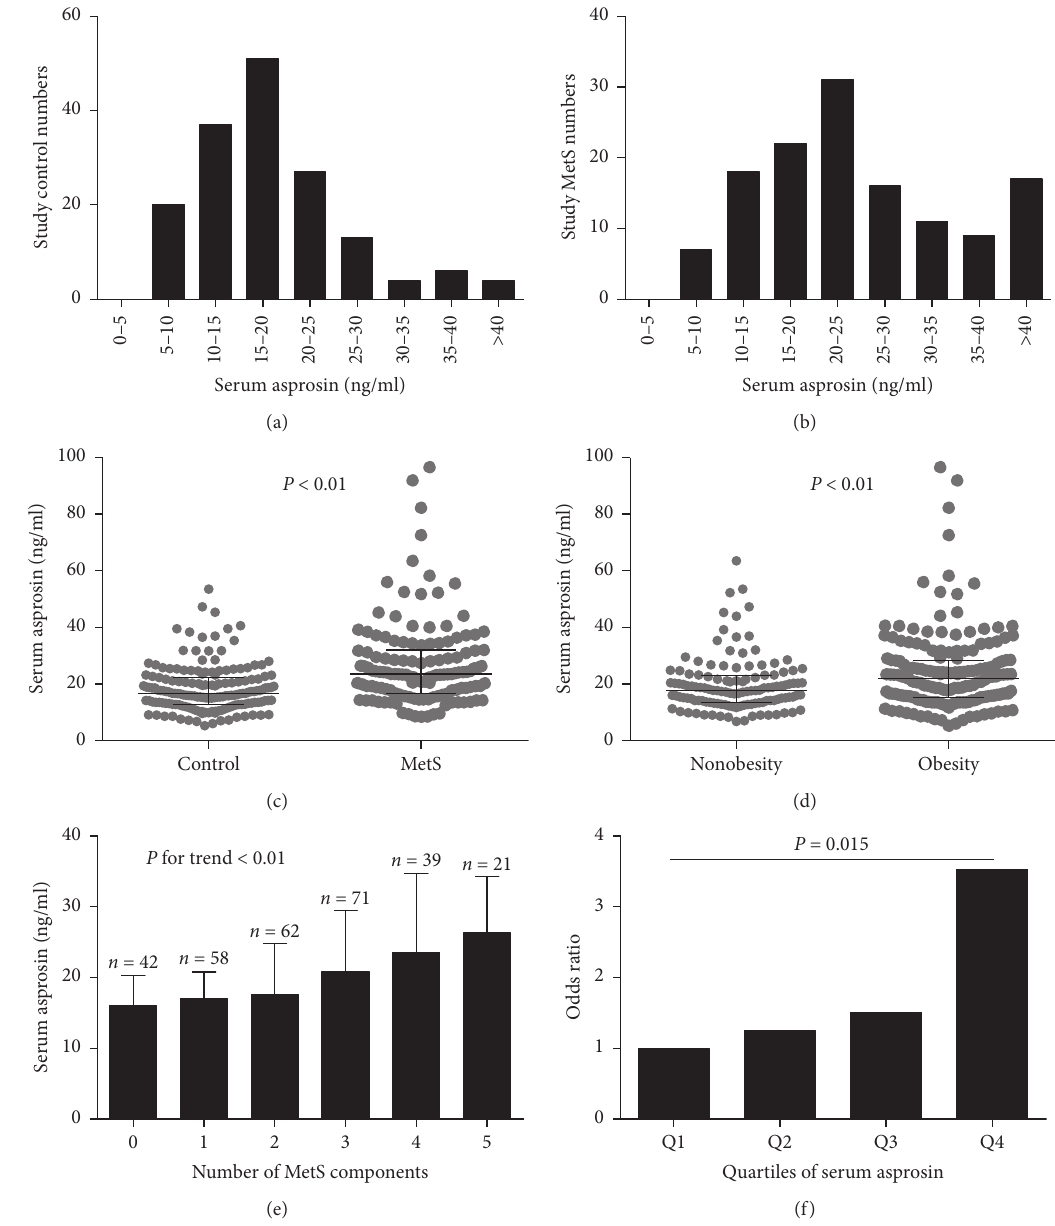
Figure 1: Serum asprosin levels in the study population. (a) Distribution of serum asprosin levels in 162 control subjects; (b) distribution of serum asprosin levels in 131 MetS subjects; (c) serum asprosin levels in control and MetS subjects; values were provided as median with interquartile range and log-transformed before analysis; (d) serum asprosin levels in the whole study population according to waist circumference (nonobesity: waist circumference < 85cm in men or 80cm in women and obesity: waist circumference ≥ 85cm in men or 80cm in women); values were provided as median with interquartile range and log-transformed before analysis; (e) serum asprosin levels increased progressively with increasing numbers of MetS components; values were provided as median with interquartile range and log- transformed before analysis; (f) odds ratios for having MetS according to the quartiles of serum asprosin levels (reference, the